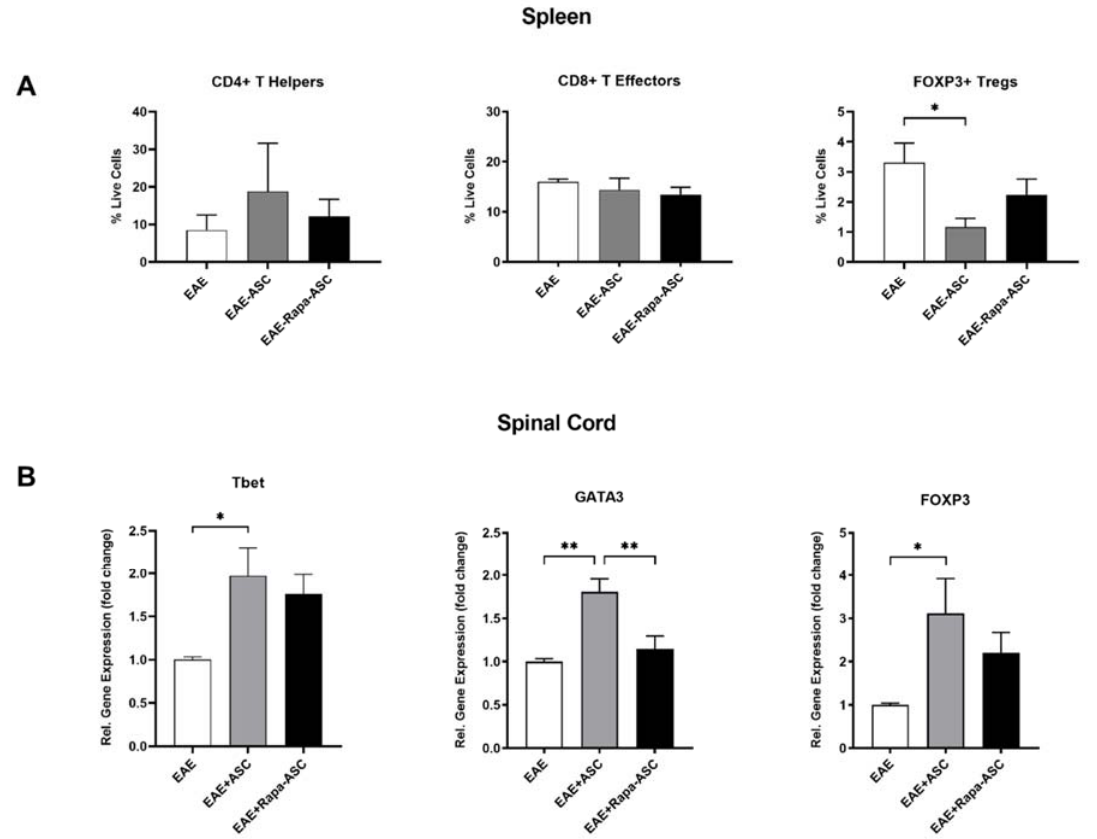
Figure 3. ASCs and Rapa-ASCs di ff erentially regulate immune cell populations in the spleen and spinal cord 10 days post-treatment. ( A ) Cells isolated from spleens of vehicle-treated EAE ( n = 5), ASC-treated EAE ( n = 5), and Rapa-ASC-treated EAE ( n = 6) mice were analyzed for canonical T cell markers with flow cytometry and represented as percentage of live cells. ( B ) Gene expression analysis of key T cell transcription factors in whole EAE spinal cords was performed using RT-qPCR. Data are presented as the mean ± SEM. Data are normalized to the housekeeping gene β -actin and represented as the relative fold change over vehicle-treated EAE controls. Statistical analysis was performed using a one-way analysis of variance (ANOVA) and Tukey’s post-hoc multiple comparisons test. Statistical di ff erences between groups are marked with * p < 0.05; ** p < 0.01. FOXP3, Forkhead Box P3; Tbet, T-box expressed in T cells; GATA3, GATA Binding Protein